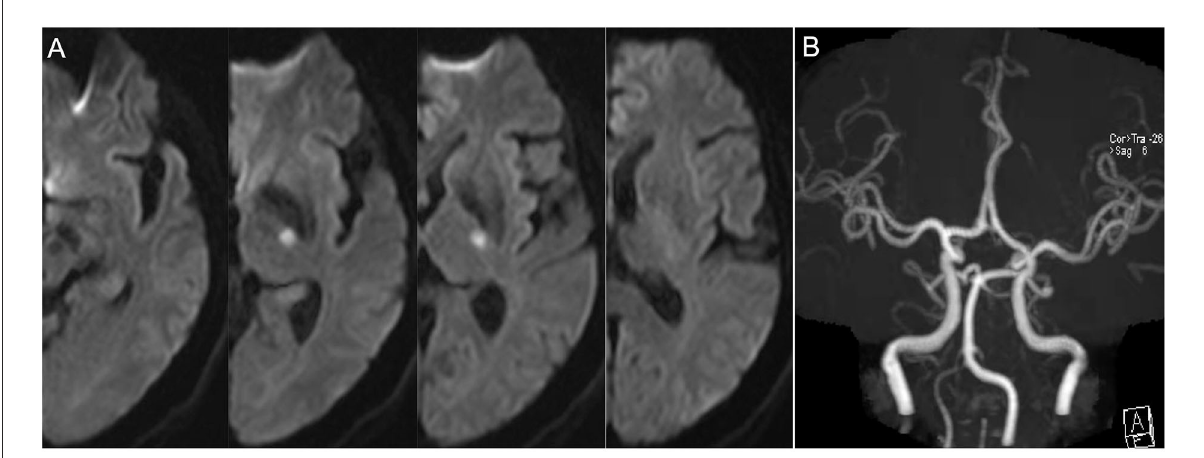
FIGURE1 Representative case of non-progressive infarction. (A) The infarct slice number < 3 on 5mm thick axial DWI images and the patient had no progressive infarction. (B) MRA showed no obvious etiologies (vasculitis, dissection, Moyamoya disease) that led to ischemic stroke.